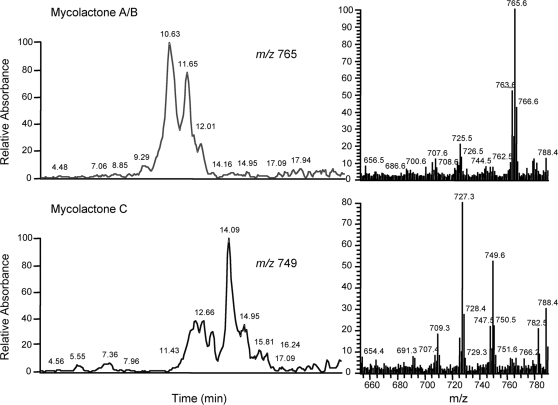
Structural integrity of mycolactone following diffusion into internal organs.The ion trace for m/z 765 (Mycolactone A/B) and m/z 749 (Mycolactone C), and the corresponding MS/MS spectra are shown for the spleen lipid extract of a mouse injected with mycolactone via the sc route. Data are representative of two independent experiments.